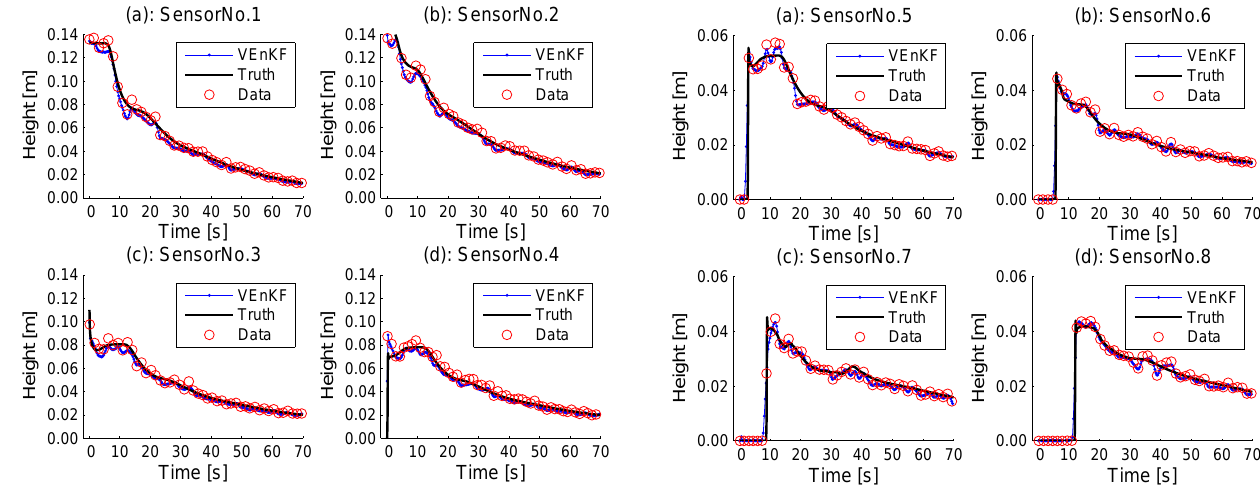
Fig. 4. Experiment 1: Comparison of VEnKF estimates, true water depth and data of the dam break experiment for the first four sensors at the upstream end.